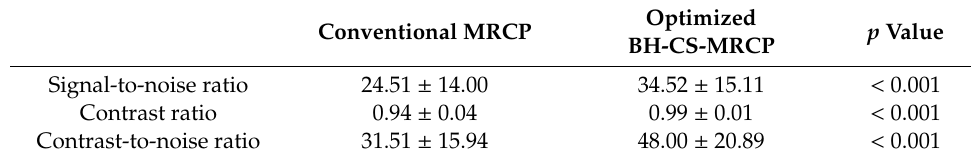
Table 3. Results of quantitative image analysis.